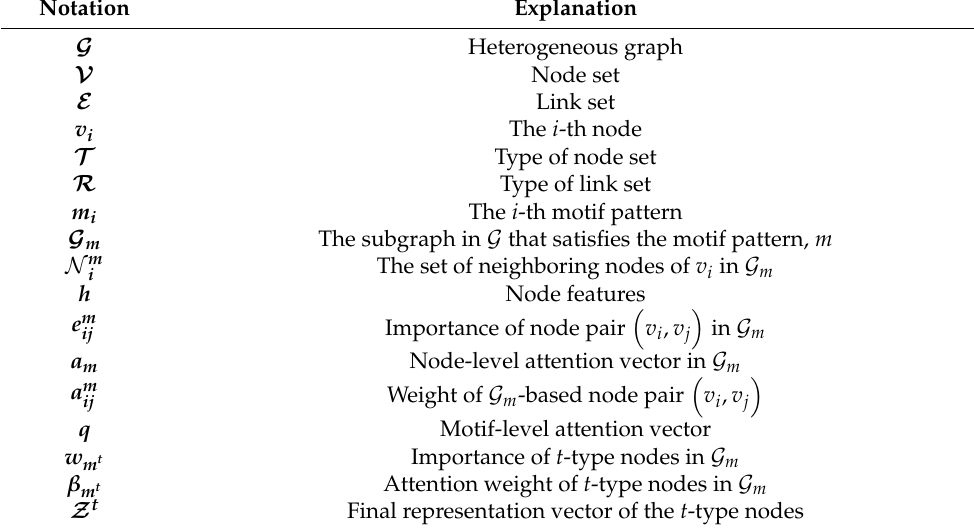
Table 1. Notations and Explanations.